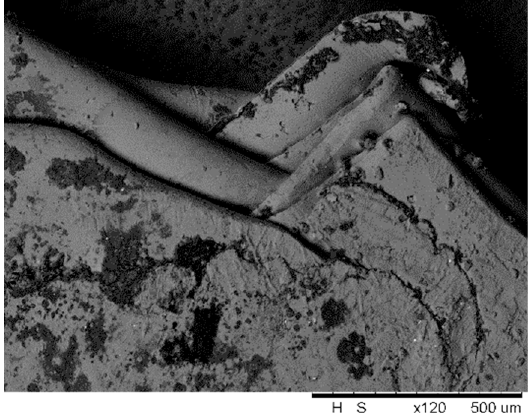
Figure 20. Electron micrograph of the cell wall folding.